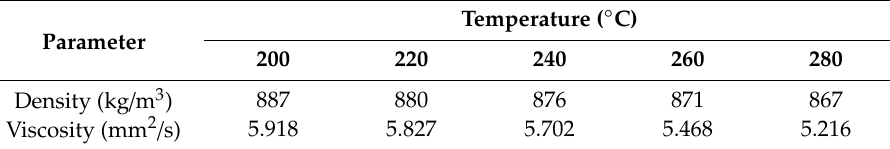
Table 8. Biodiesel density and viscosity at various temperatures.